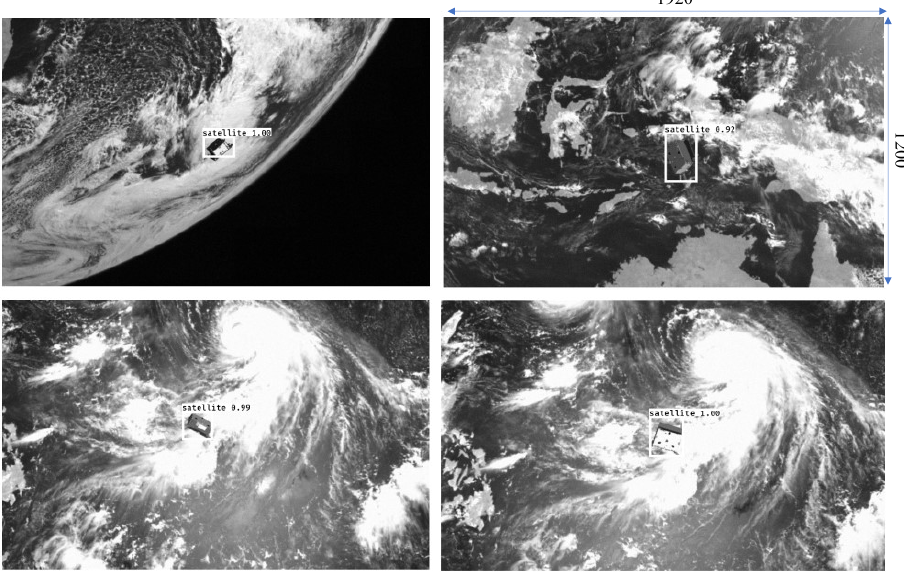
Figure 9. Spacecraft Detection and Bounding with